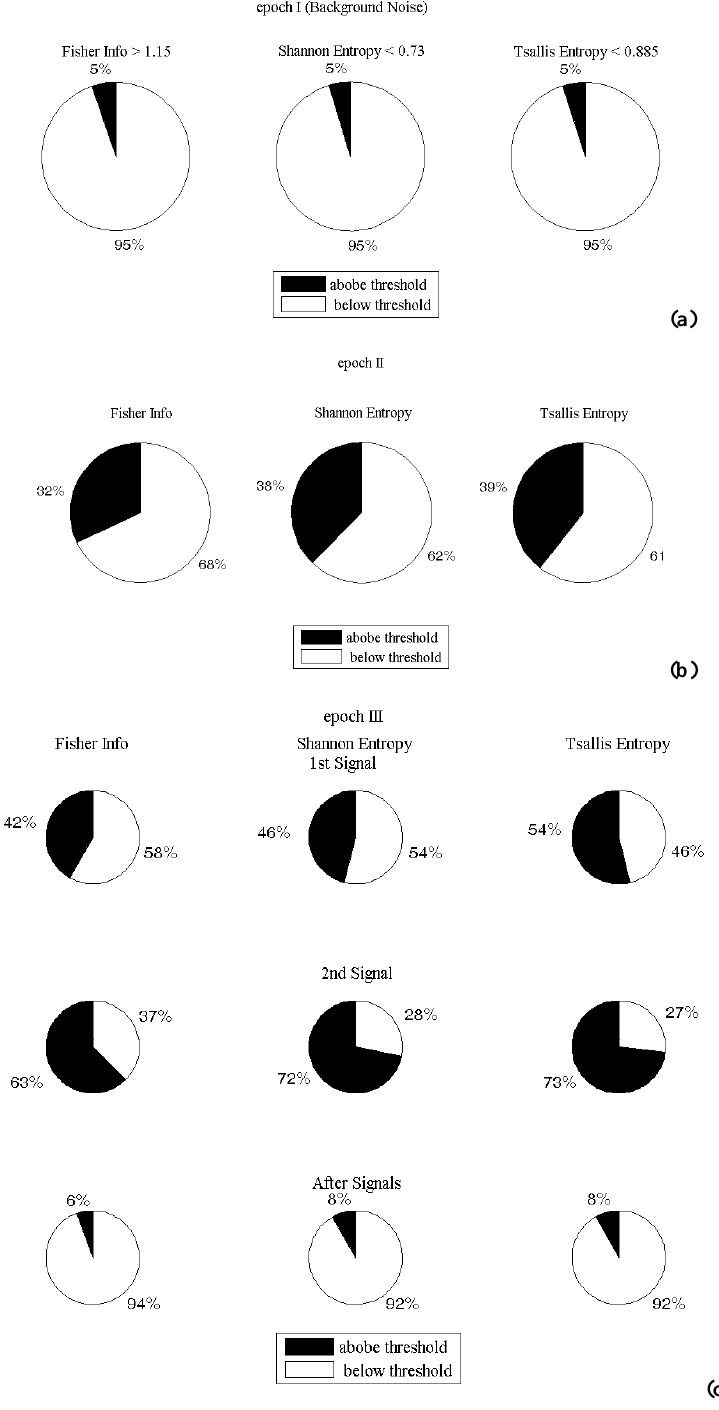
Fig. 6. Percentage of Fisher information, Shannon entropy and Tsallis entropy values lying “above” the background information/entropy threshold. (a) Threshold values calculated at the 95% limit of the information/entropy values distribution during the first, background, phase of the signal (epoch I: 3 August 1999, 00:00:00 UT to 12 August 1999, 23:59:59 UT). “Above threshold” are considered values of Fisher information > 1.15, Shannon entropy < 0.73, and Tsallis entropy < 0.885. (b) Percentage of Fisher information, Shannon entropy and Tsallis entropy values “above threshold” for the second, early-preparatory, phase of the signal (epoch II: 1 September 1999, 00:00:00 UT to 4 September 1999, 11:51:00 UT). An increase of the “above threshold” percentage is noted for all metrics, compared to the background percentages, signifying an increased order in the signal. (c) The same representation as in (b) for the third, main, phase of the signal (epoch III: 5 September 1999, 11:51:01 UT to 7 September 1999, 23:59:59 UT). A further increase of the order is noted inside the two strong signal bursts, while the percentages after the two bursts denote “background” behaviour. It is also pointed out that the second signal appears to be more organized than the first one.